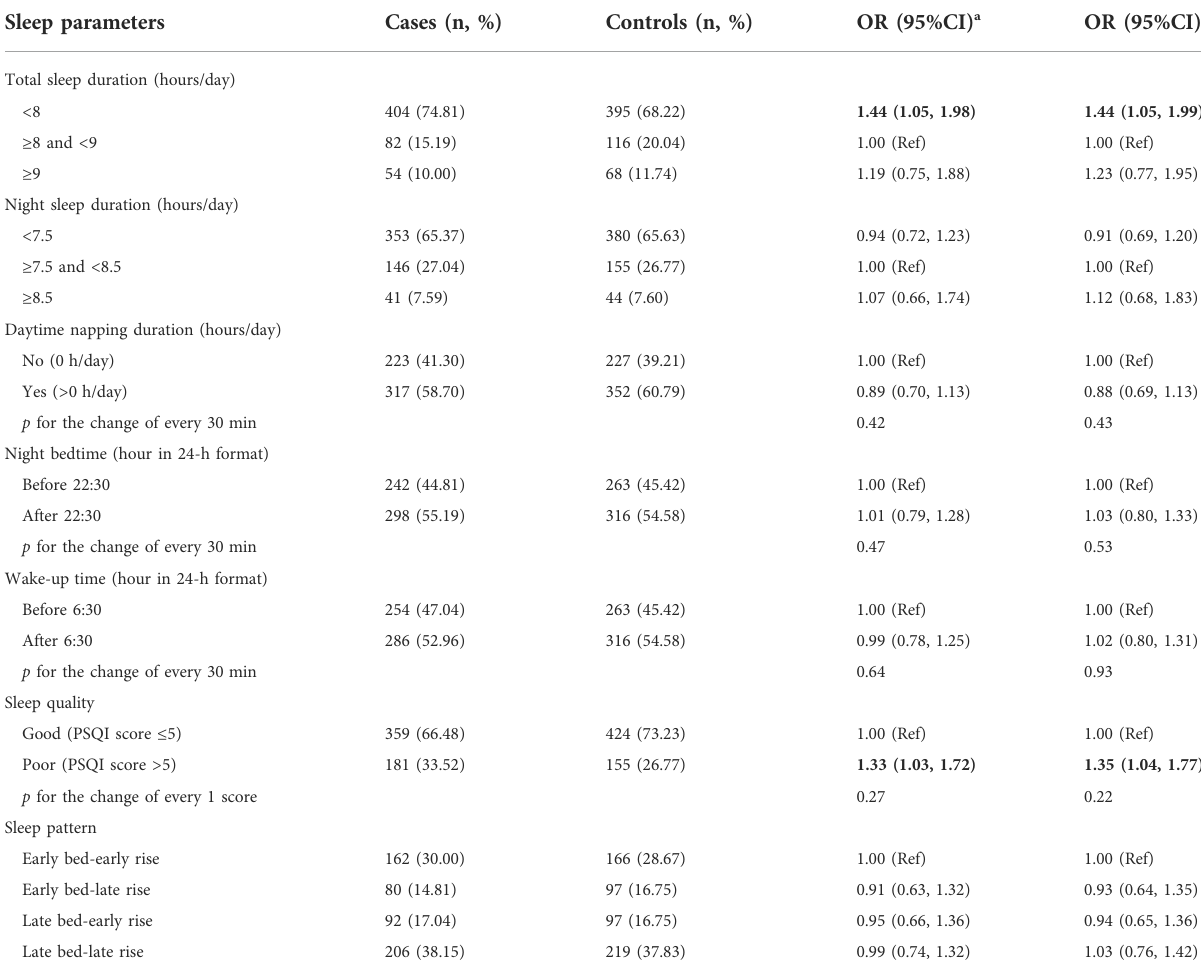
TABLE 2 Associations between sleep status and asthenozoospermia risk. Sleep parameters